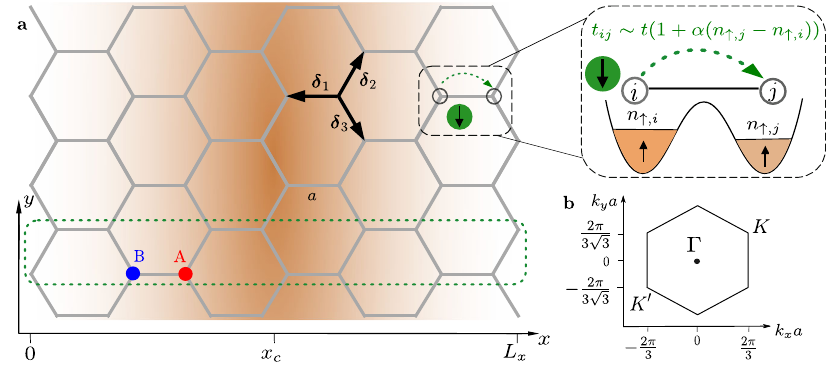
Fig. 1 Description of the strain scheme. a Representation of the density-assisted hopping model on the honeycomb lattice of length L x = 2 x c . The parameter a denotes the lattice spacing. The shaded area depicts the inhomogeneous Bose – Einstein condensate. In the zoomed panel, we depict the hopping process of the ↓ atoms between two neighboring sites occupied by a different amount of ↑ atoms. The unit cell of the lattice where we assume translational invariance in the y direction is shown by the green dotted line with zig-zag terminations. b First Brillouin zone of the honeycomb lattice where ffiffiffi p a Þ and K 0 ¼ (cid:2) K are Dirac points at K ¼ ð 2 π = 3 a ; 2 π = 3 3